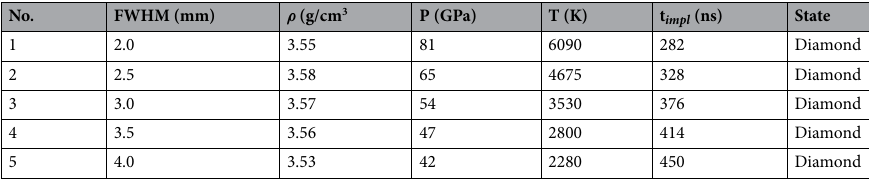
Table 5. Achieved physical conditions in compressed carbon using bunch intensity = 2 × 10 11 uranium ions, bunch length = 200 ns, particle energy = 2 GeV/u, initial sample radius, R si = 500 μm, sample mass = 17.7 mg/ cm.